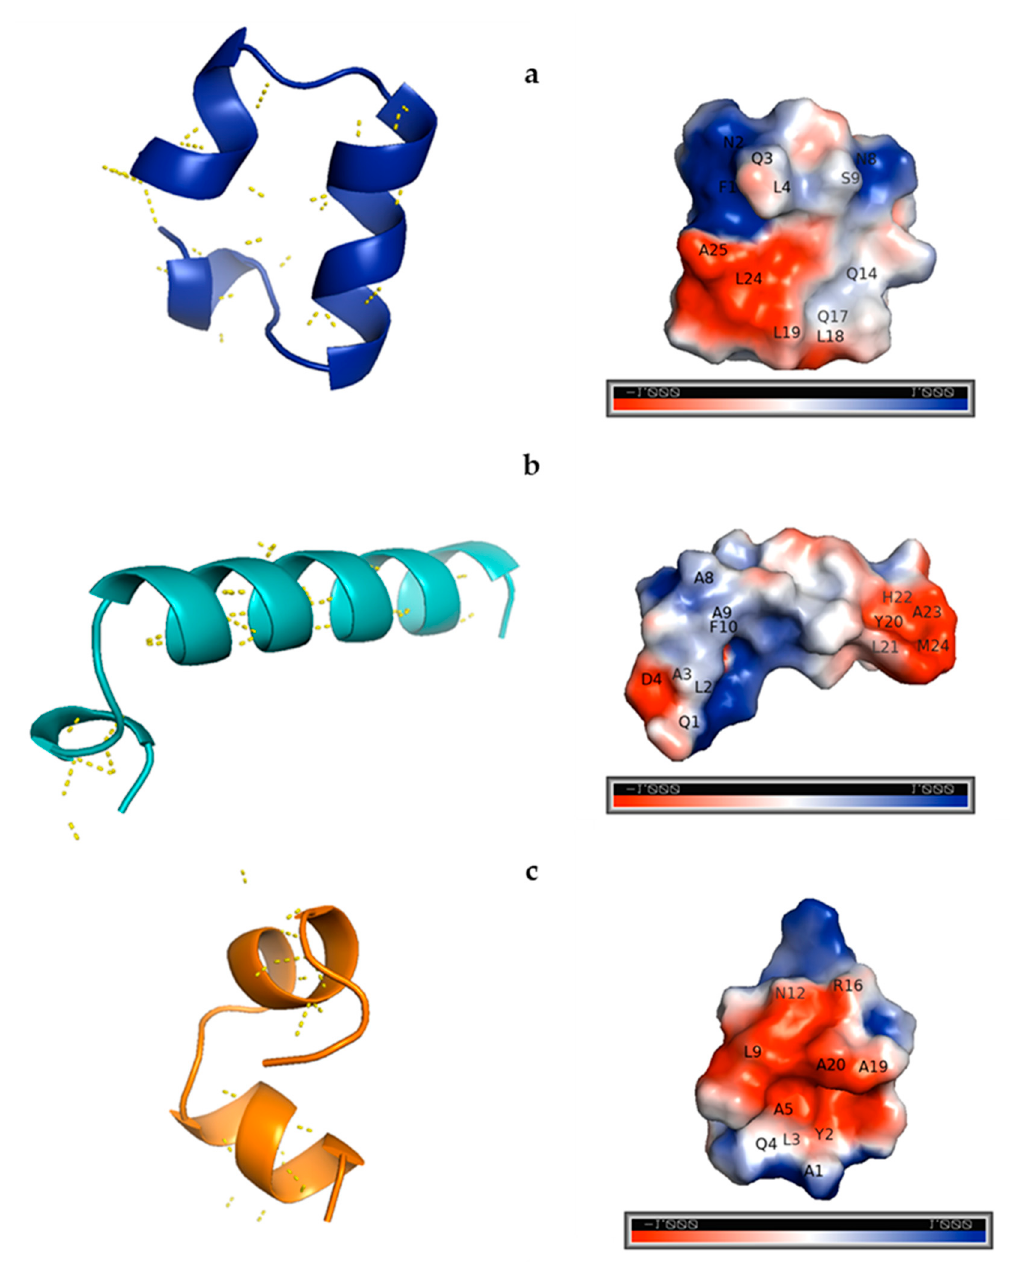
Figure 1. Left side: predicted 3D structure of the synthesized peptides and polar interactions between amino acids. Right side: electrostatic potential according to the predicted structures of the synthesized peptides. The QUARK online Ab initio protein structure algorithm was used to obtain the models and PyMOL molecular graphics system version 2.3.4 was used to generate the 3D model images. The Adaptive Poisson–Boltzmann Solver (APBS) plugin version 3.7 was used to calculate and predict the electrostatic potential surface. The electrostatic potential scale ranges from − 1 to + 1. Amino acids contributing with the potential are represented as one letter codes and their number in the sequence.